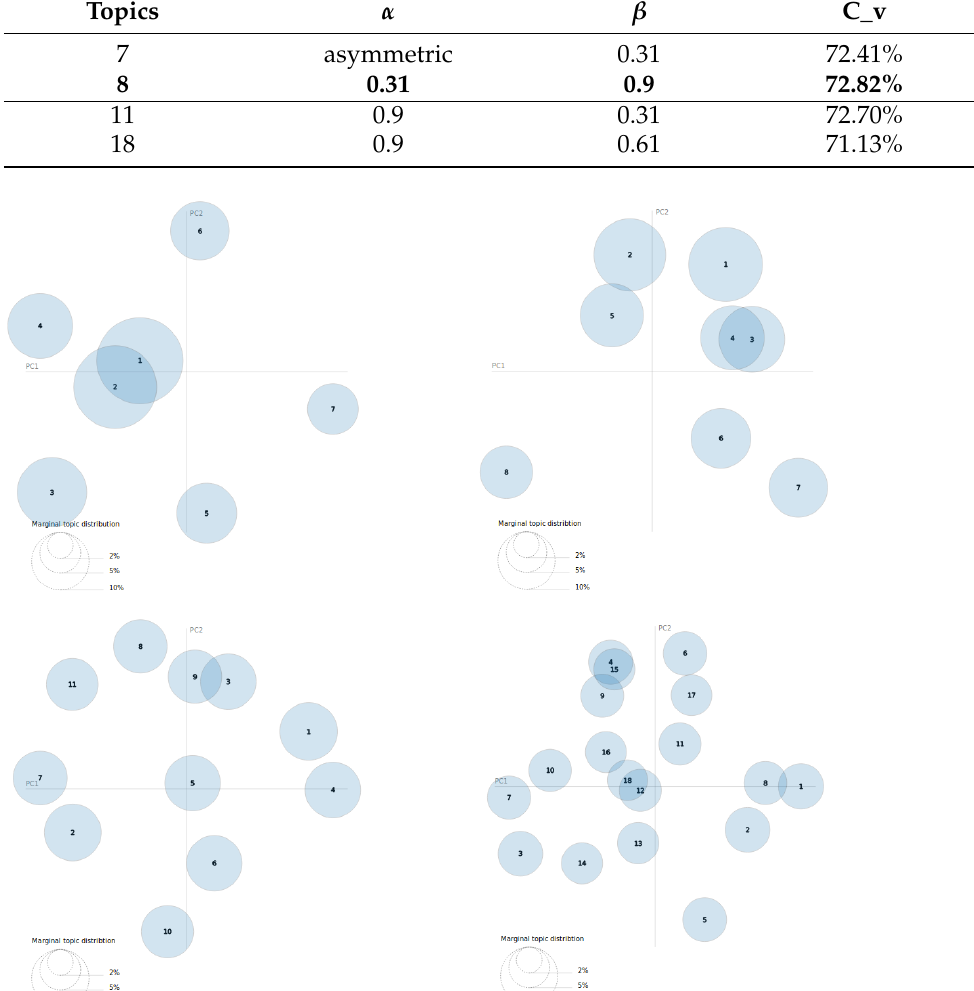
Figure 7. Visualization of the distribution of the topics in the best LDA